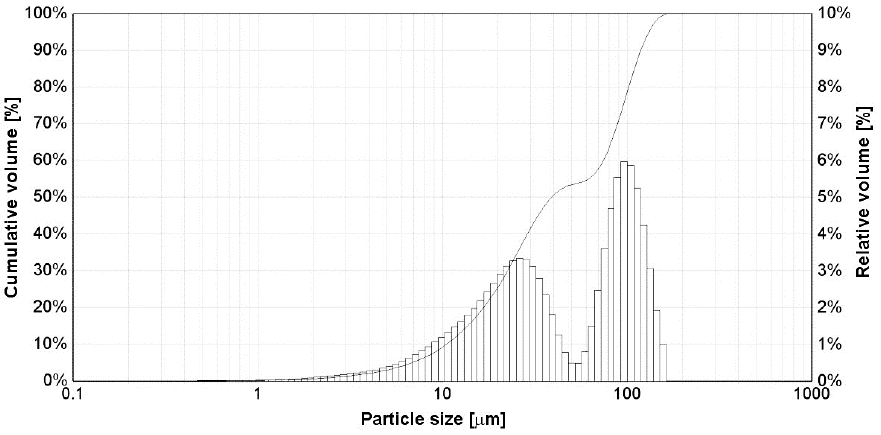
Figure 5. The size distribution of graphene oxide powder particles obtained by laser analysis.